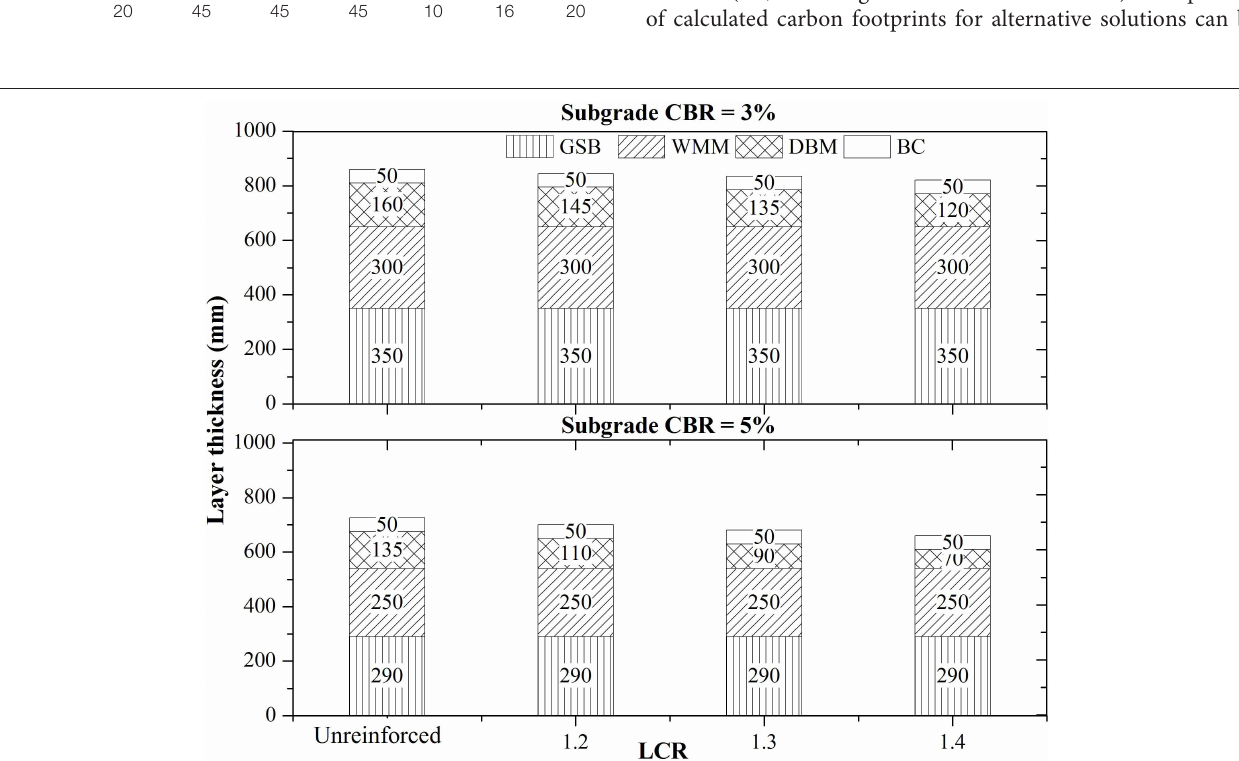
FIGURE 4 | Design charts showing thicknesses of unreinforced and geogrid reinforced flexible pavements using LCR approach based on Objective-2 for the traffic of 100 MSA with subgrade CBRs equal to 3 and 5%.